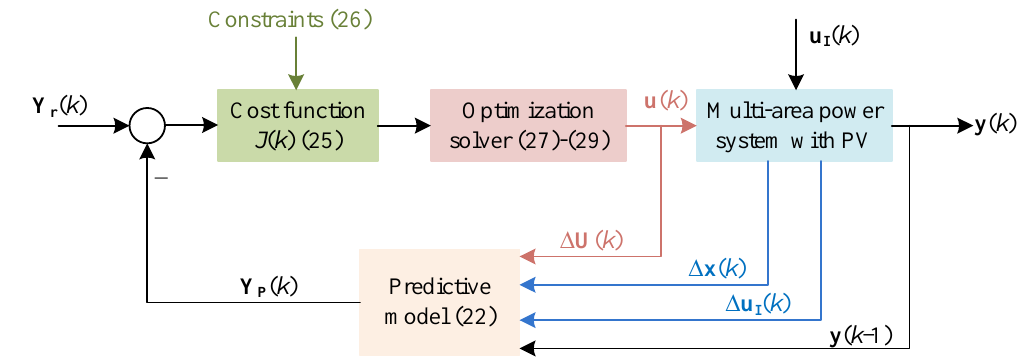
Figure 2. The structure of MPC method for the optimal LFC issue of a multi-area interconnected power system with PV generation.